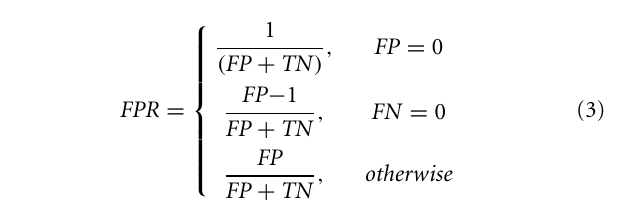
FIGURE 5 | Result of the recursive least-squares noise canceling adaptive filter. Using the implementation of He et al. (2004, 2007), VEOG and HEOG bipolar time series are used as reference noise input channels to the adaptive noise canceling structure. The time series shown in this figure, in order from